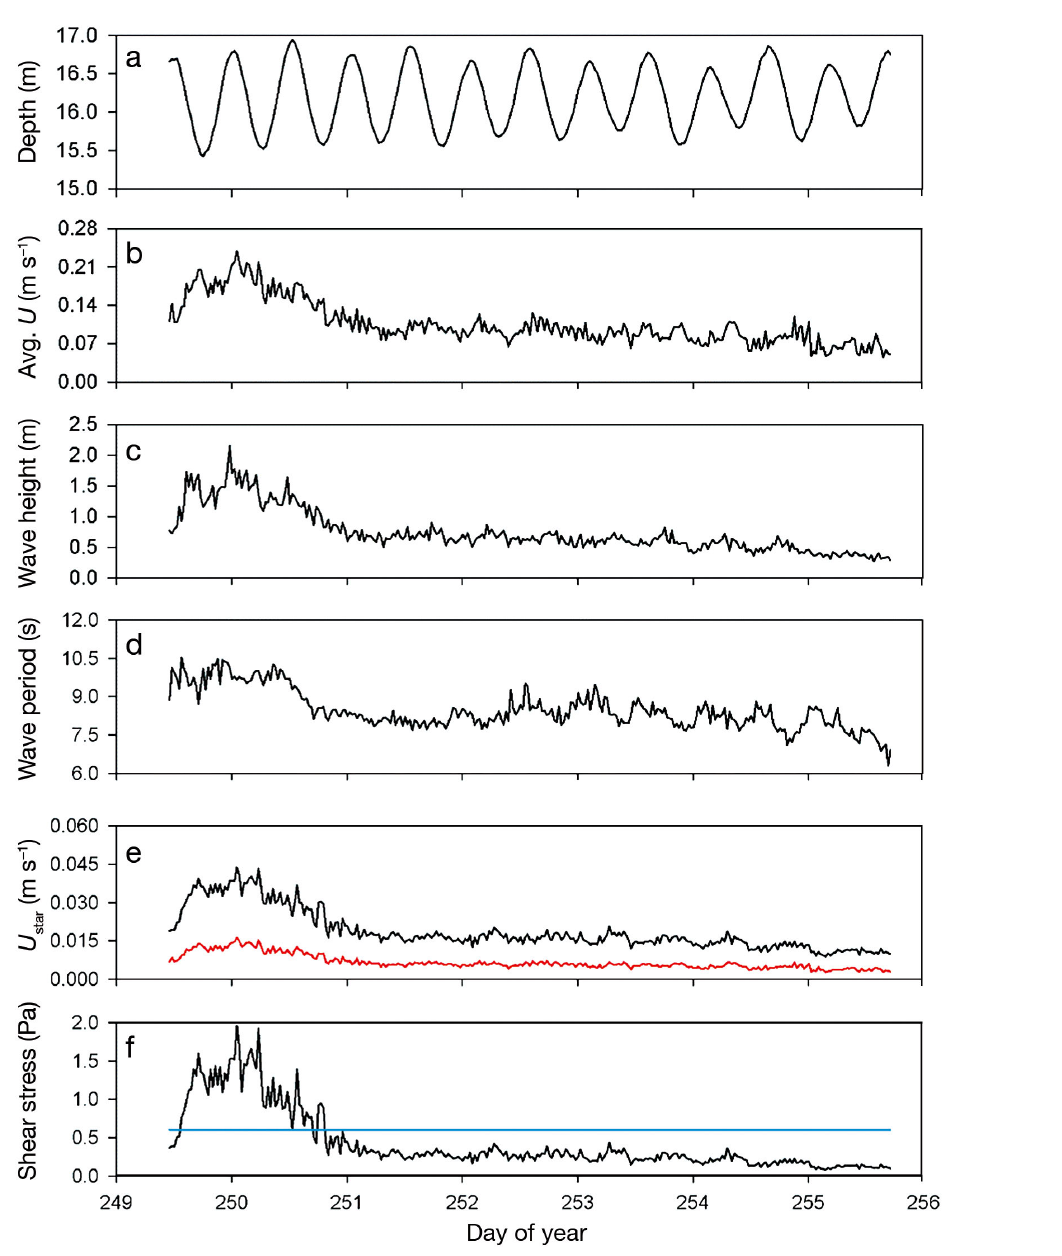
Fig. 2. Jordan Bay physical oceanography data from September 2016 from near cage. (a) Change in water depth from the CTD; (b) average current speed ( U) ; (c) significant wave height; (d) wave period; (e) calculated combined wave current shear velo - city ( U star ) (black) and current only shear velocity (red); (f) calculated shear stress (black) and the maximum shear stress of the Gust chamber erosion experiments